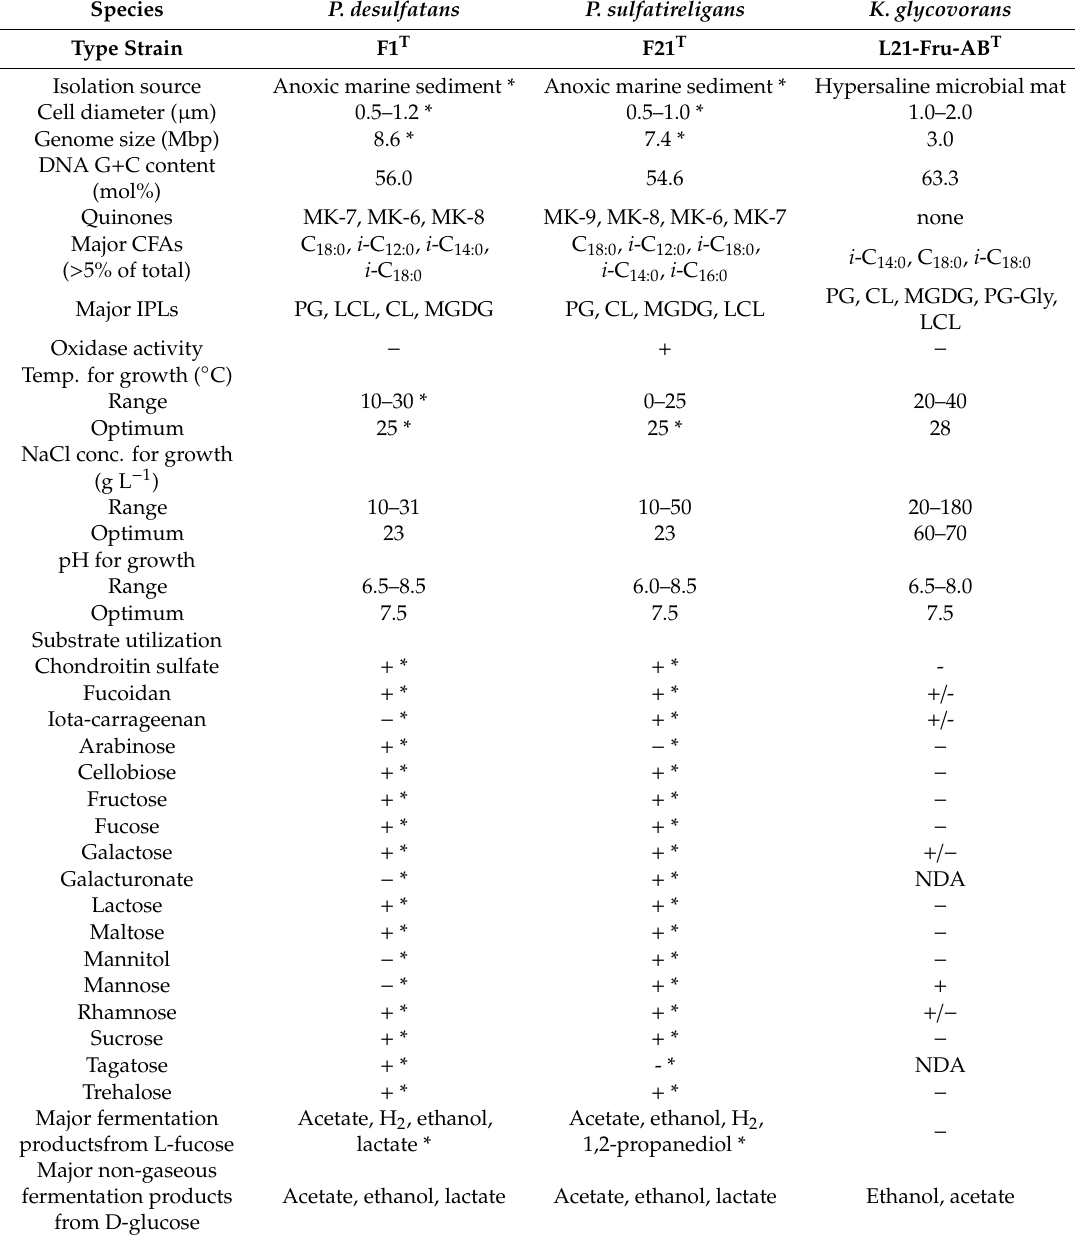
Table 2. Di ff erential traits of strain F1 T , F21 T and Kiritimatiella glycovorans L21-Fru-AB T . Abbreviations: MK, menaquinone; CL, cardiolipin; LCL, lysocardiolipin; MGDG, monogalactosyl diglyceride; PG, phosphatidylglycerol; PG-Gly, phosphatidylglycerohexose; + , positive; +/ − , unstable, ceasing growth after the first transfer; − , negative; NDA, no data available. Major cellular fatty acids (CFAs), intact polar lipids (IPLs), quinones and fermentation products are reported in order of abundance. The CFA and IPL data for K. glycovorans were generated during this study, other data for K. glycovorans were obtained from Spring, et al. [9]. * Data from Van Vliet, et al. [8].